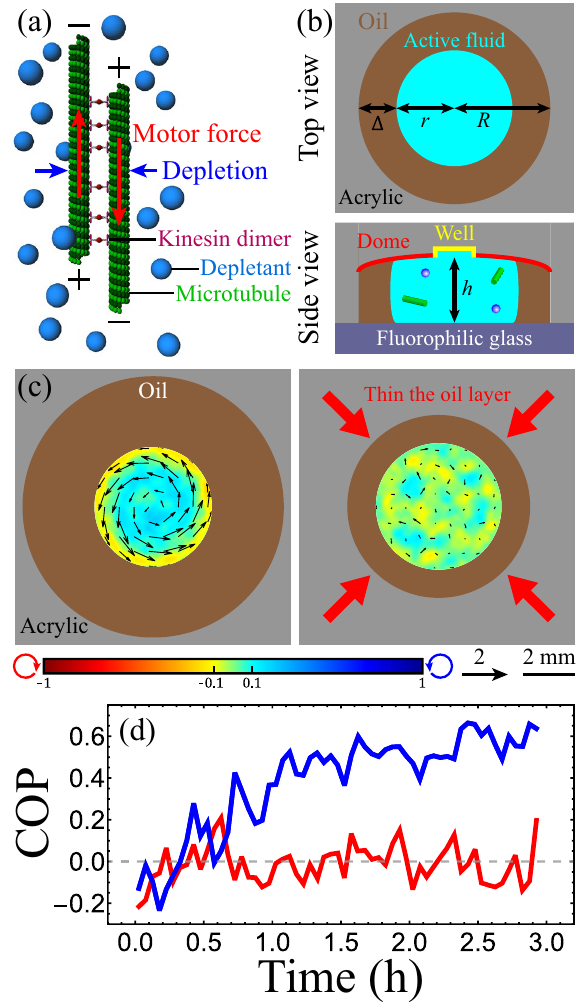
Figure 1. Flows within an active droplet immersed in oil are affected by the thickness of the oil layer. ( a ) Mechanism behind the activity of microtubule–kinesin active fluid. Microtubules are bundled by depletion (blue arrows) and bridged by kinesin motor dimers that slide pairs of antiparallel microtubules apart (red arrows). Figure adapted from Bate et al . 36 ( b ) Schematic of fluidic device used to compress droplets. The device ceiling was curved into a dome-like shape (red), and a well was drilled (radius 1 mm, depth 0.2 mm) on top of the dome (yellow). The curved ceiling caused the active droplet to remain stationary at the dome center. ( c ) An active droplet ( r ≈ 2.4 mm, h ≈ 2 mm) confined in an oil layer whose thickness was 2.6 mm developed a circulatory flow (left). The circulatory flow was suppressed by decreasing the oil layer thickness to 1.1 mm (right). Black arrows represent time-averaged velocity flow fields normalized by the flow mean speed. The color maps represent normalized vorticity distributions, with red and blue representing clockwise and counterclockwise vorticities, respectively. Videos of the flows in both systems are available in Supplementary Video S2. ( d ) Evolution of circulation order parameter (COP) of flows within the active droplets in c (blue: 2.6- mm oil thickness; red: 1.1-mm oil